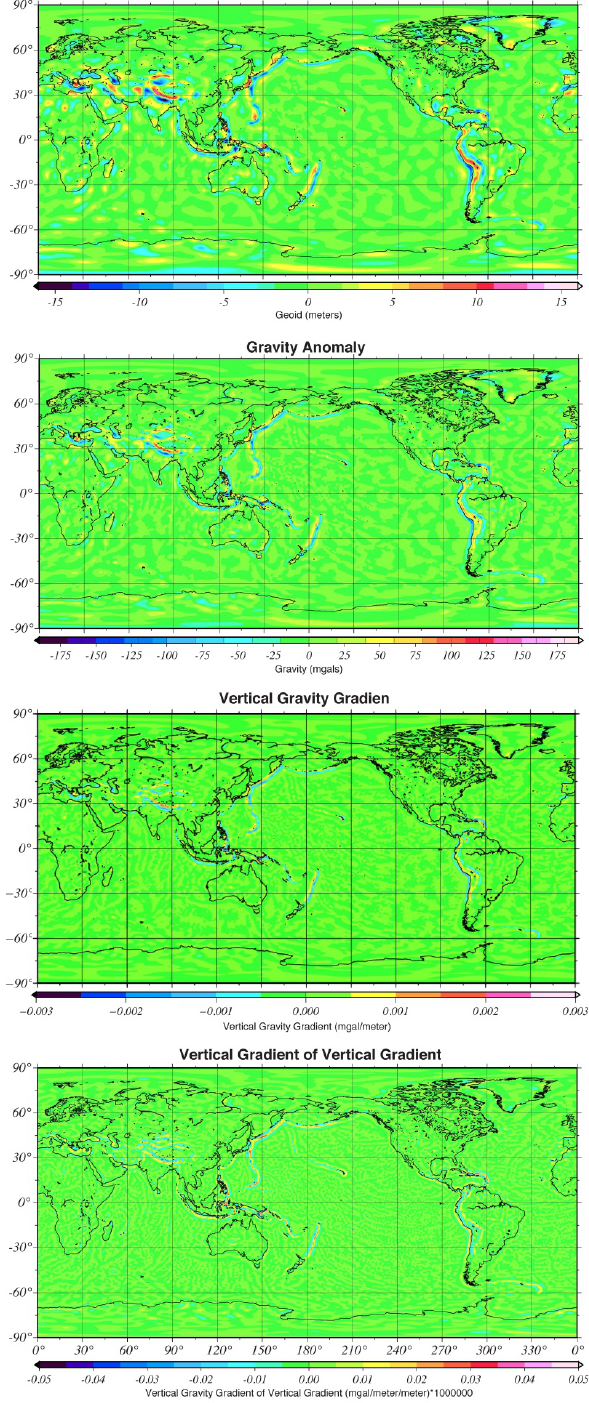
Figure 7. Residual geoid, gravity, vertical gravity gradient, and ver- tical gradient of vertical gravity gradient for spherical harmonic de- grees 31–464. Color scale weighted so that each color has same number of data